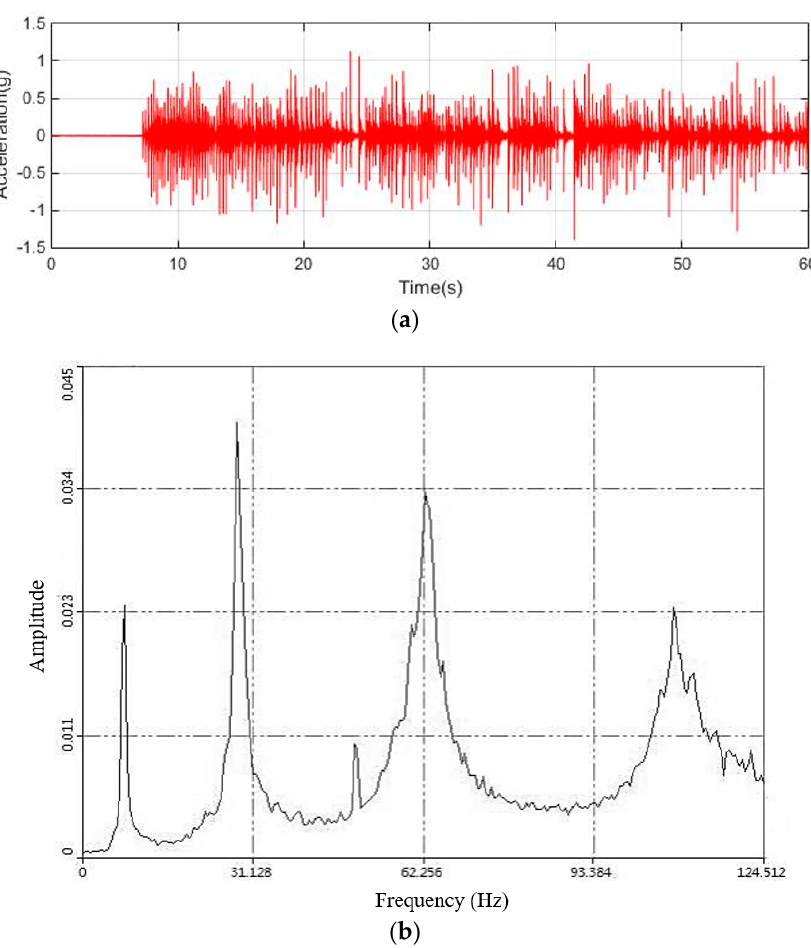
Figure 5. Acceleration history and power spectral density. ( a ) Acceleration history. ( b ) Power spectral density.